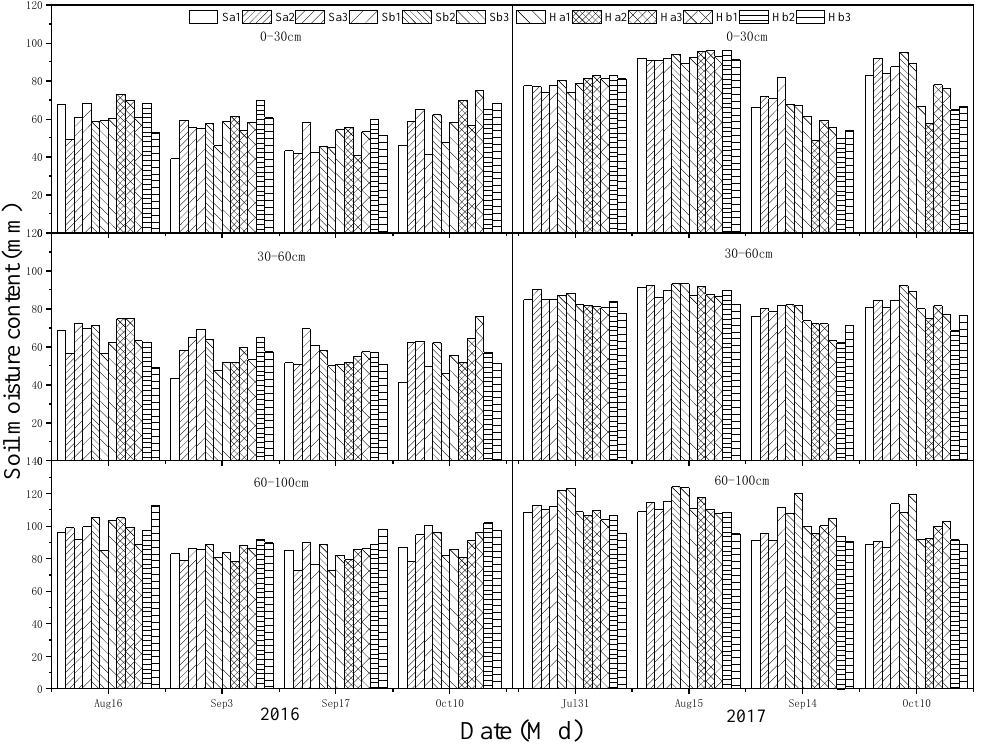
Figure 3. Soil moisture dynamic change in the 0 – 30, 30 – 60 and 60 – 100 cm soil layer of the 2016 – 2017 summer-maize growing seasons. Table 3. Soil moisture consumption and ET of summer maize during the 2016 and 2017 growing seasons.